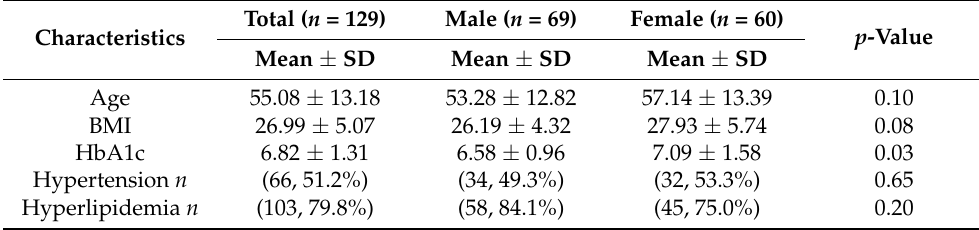
Table 1. Basic characteristics of 129 psychiatric patients with diabetes.